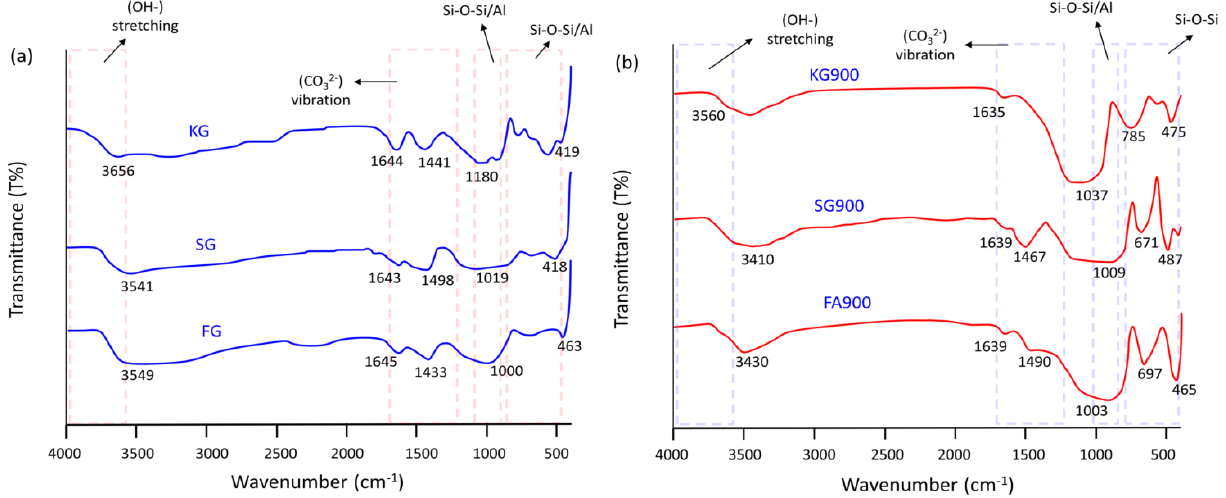
Figure 4. Fourier-transform infrared spectroscopy (FTIR) of the ( a ) unsintered and ( b ) sintered geopolymer at 900 °C.